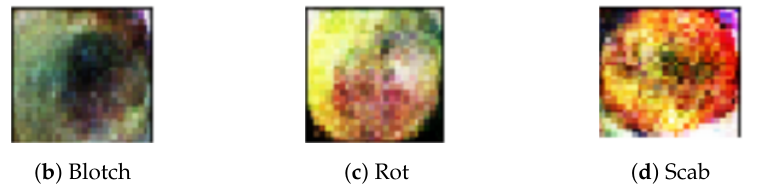
Figure 3. Examples of synthesized